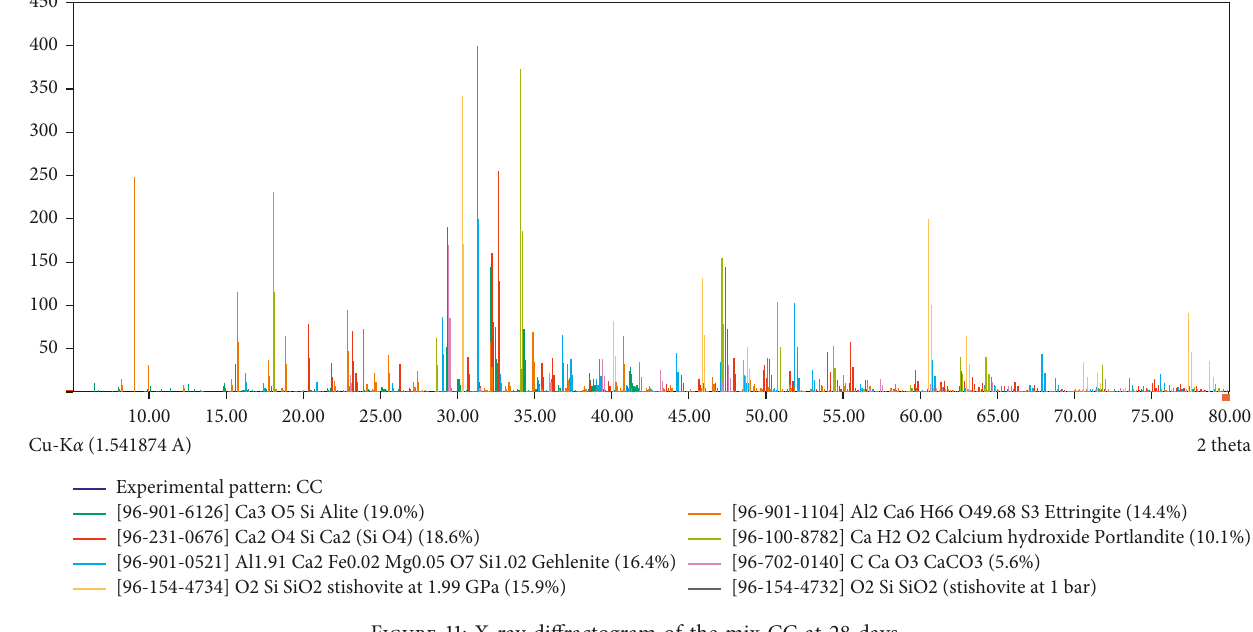
Figure 11: X-ray diffractogram of the mix CC at 28 days.